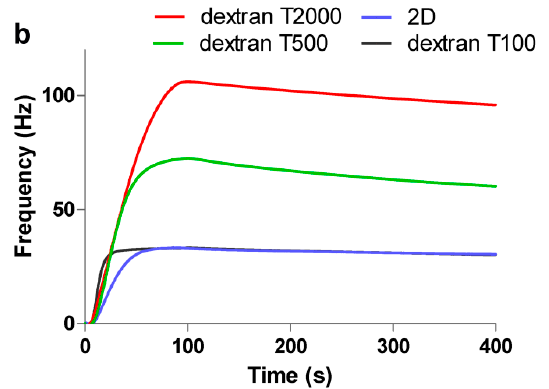
Figure 4. ( a ) The frequency response of Anti-h myoglobin 7005 to immobilized, Anti-h myoglobin 7005 at 50 µ g/mL was introduced onto the different surfaces; ( b ) Comparison of the binding of myoglobin on different surfaces, myoglobin at 4 μ g/mL was injected to the 2D and 3D surfaces respectively. All experiments were performed under the same conditions.